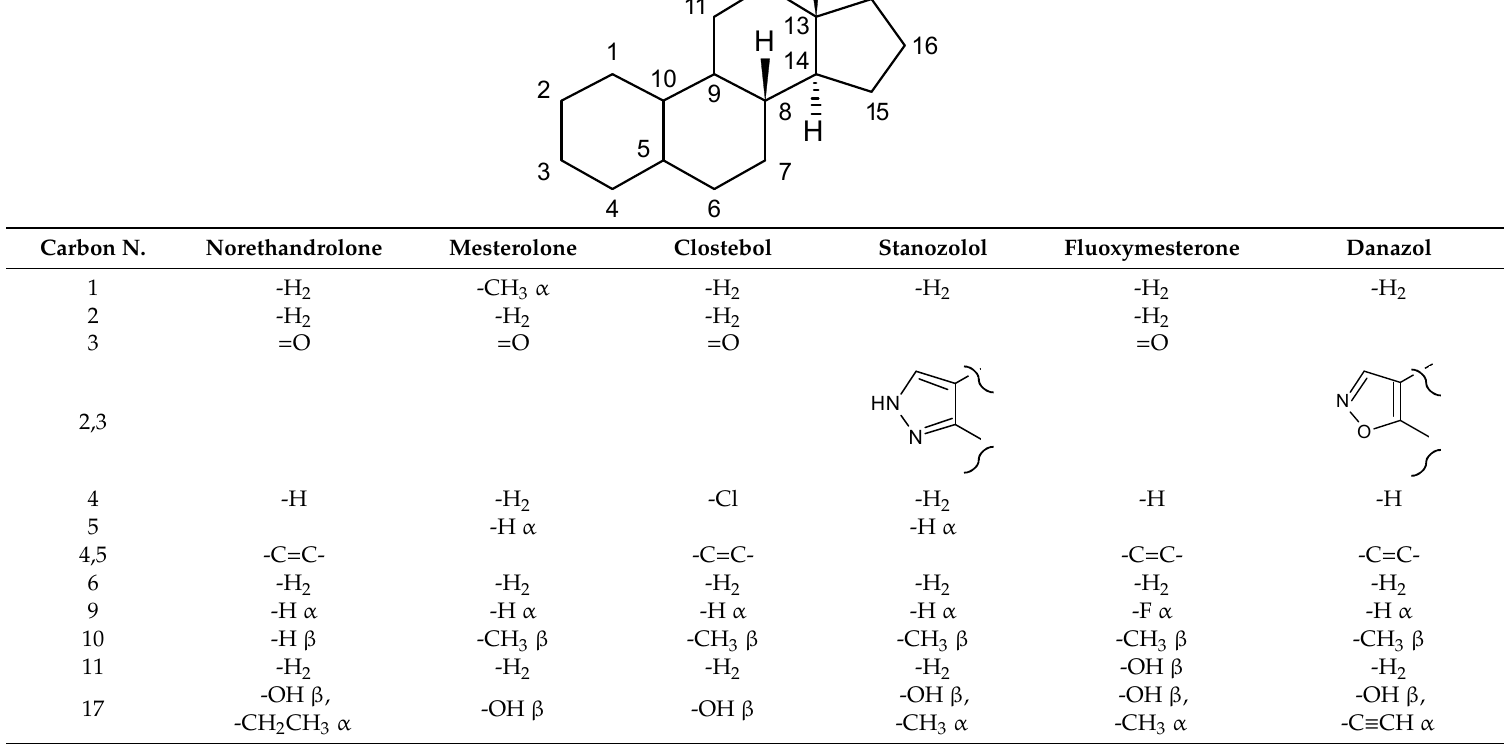
Table 2. Chemical structures of the analytes (second part).